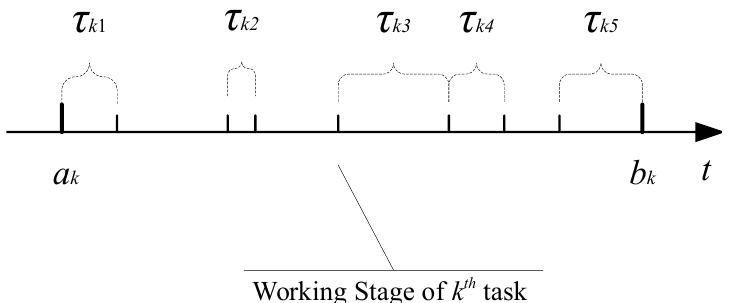
Figure 3. An example of sub-tasks in one